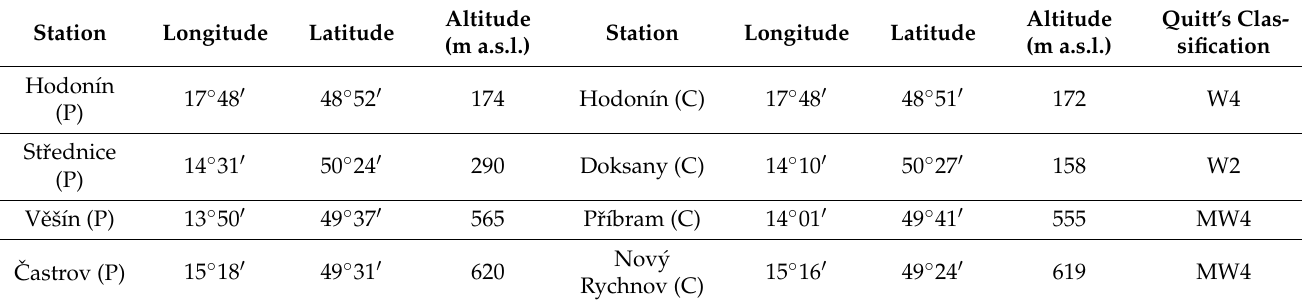
Table 1. Characteristics of the phenological (P) and climatological (C) stations including Quitt’s classification [24].